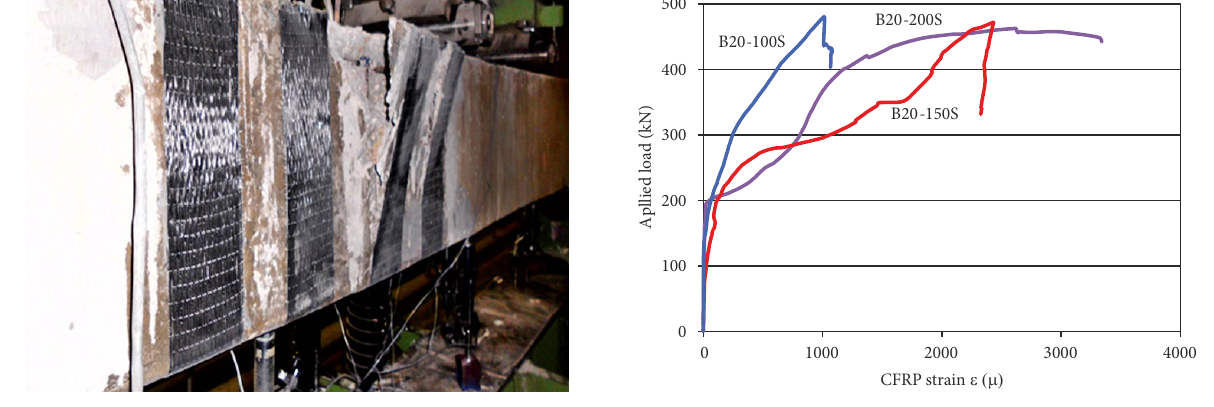
Figure 4. Delamination of concrete covert failure